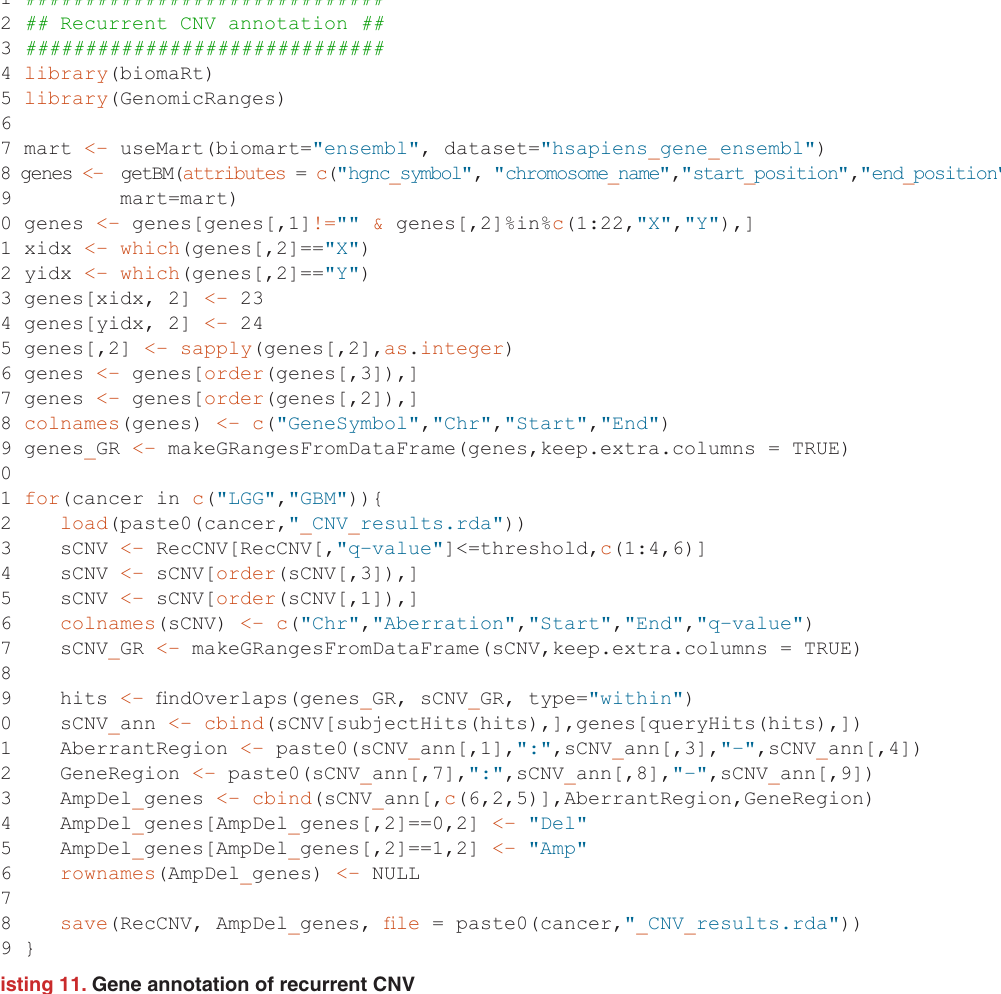
Gene annotation of recurrent CNV. The aberrant recurrent genomic regions in cancer, as identified by GAIA, have to be annotated to verify which genes are significantly amplified or deleted. Using biomaRt we retrieved the genomic ranges of all human genes and we compared them with significant aberrant regions to select full length genes. An example of the result is shown in Table